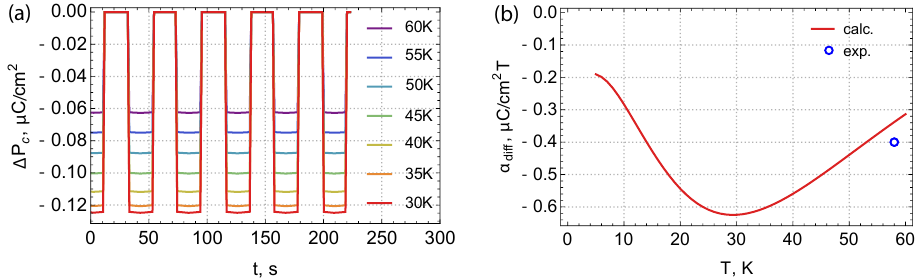
Figure 6. ( a ) The simulated quasi–linear magnetoelectric effect at the boundary between the antiferro- magnetic and ferrimagnetic phases for various temperatures. The amplitude of the field oscillations is the same and corresponds to Figure 5. ( b ) Temperature dependence of the magnetoelectric coupling differential coefficient α dif f . The experimental point on the graph corresponds to the work reported in